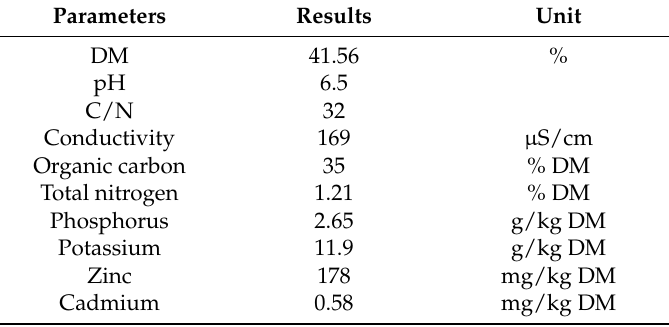
Table 1. Physico-chemical characteristics of the compost.